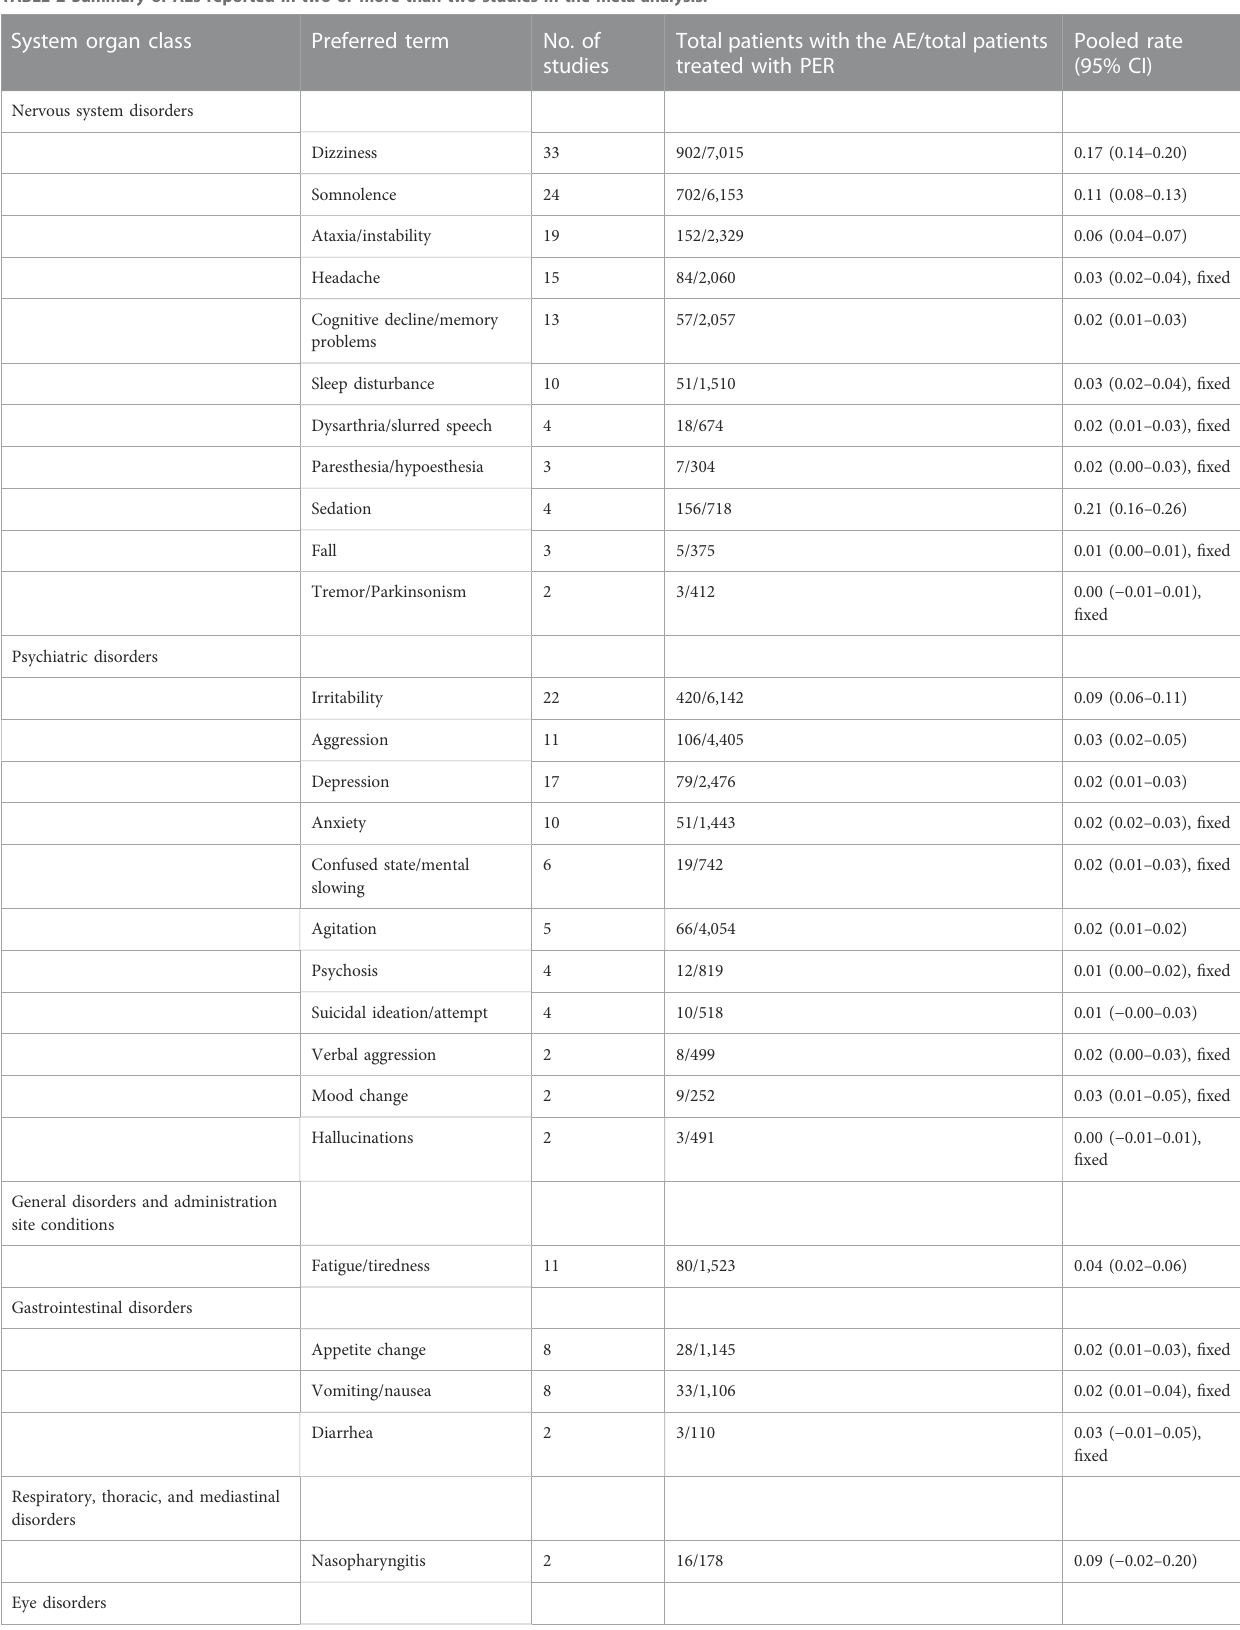
TABLE 2 Summary of AEs reported in two or more than two studies in the